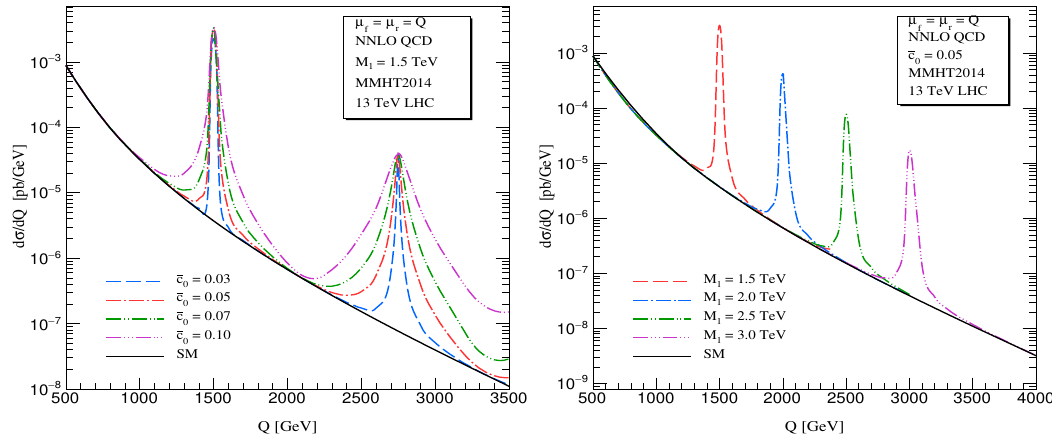
Figure 5 . Dependence of the di-lepton invariant mass distribution for the signal on the RS model parameters (cid:22) c 0 (left) and the (cid:12)rst resonance mass M 1